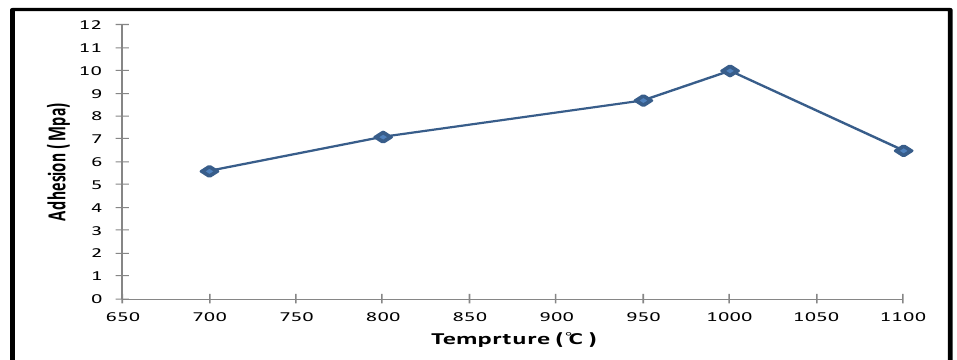
Fig.10: Relationship between temperature and adhesion of coating